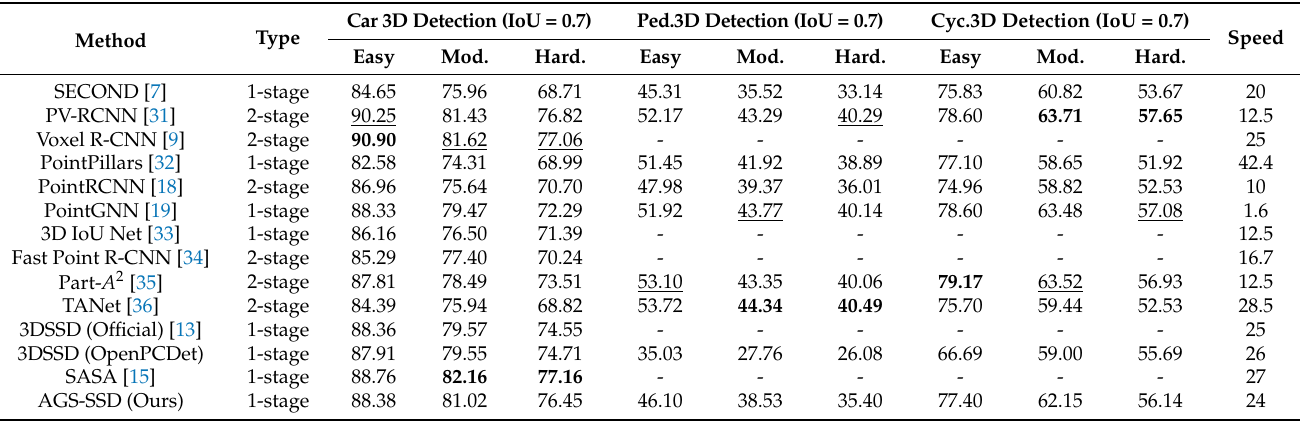
Table 1. Quantitative detection performance achieved by different approaches on the KITTI test set. All results were evaluated based on mean average precision with 40 recall positions via the official KITTI evaluation server. The results of our AGS-SSD are shown in bold, and the best results are bold, and the second best results are